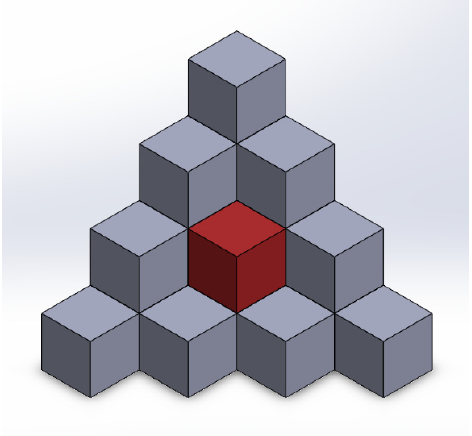
Figure 3. An example of a voxel model, one of the voxels is highlighted in color.